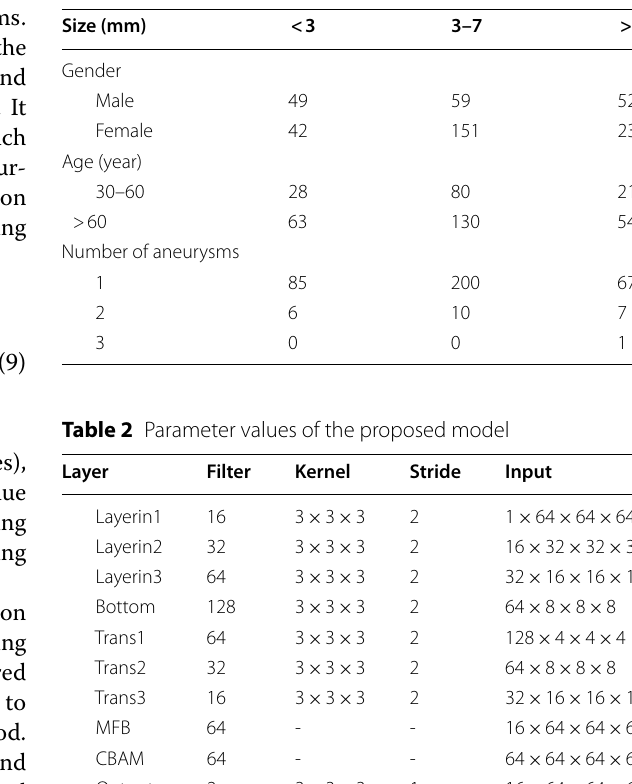
Table 1 Characteristics of the 376 clinical data samples provided